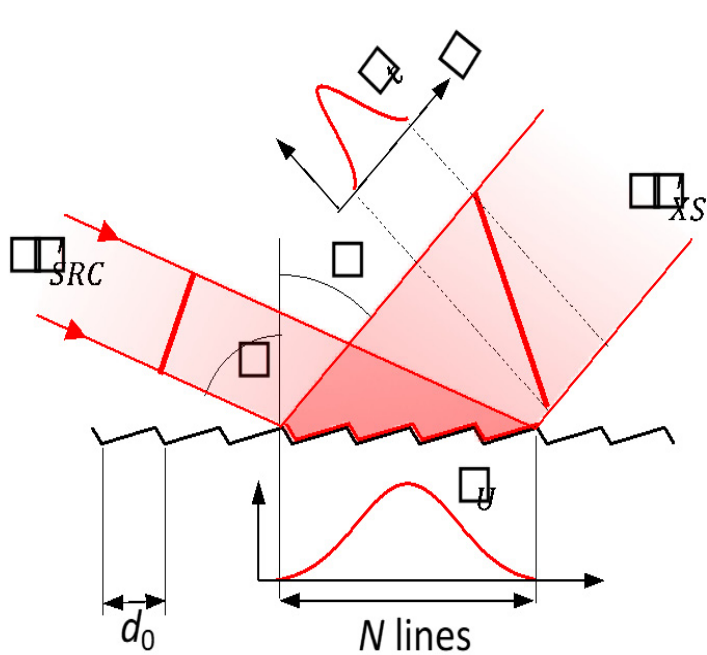
Figure 2. Scheme illustrating the pulse stretching for a gaussian coherent beam. The gaussian distri- butions indicate the intensity profiles of the beam, and the standard deviation for each distribution is